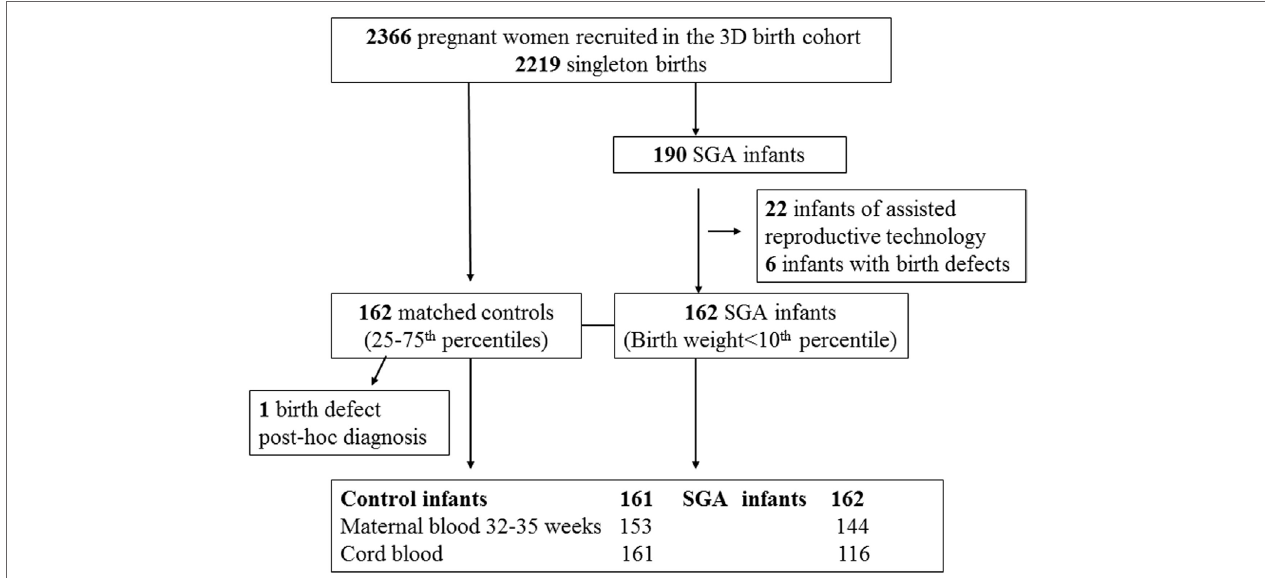
FigUre 1 | Selection of small for gestational age (SGA) and control study subjects in the 3D (design, develop, and discover) birth